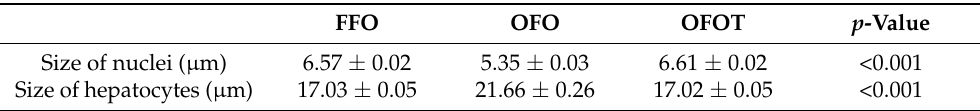
Table 5. Effects of dietary taurine on the morphometrics of the liver of channel catfish ( Ictalurus punctatus ) fed oxidized-fish-oil diets.